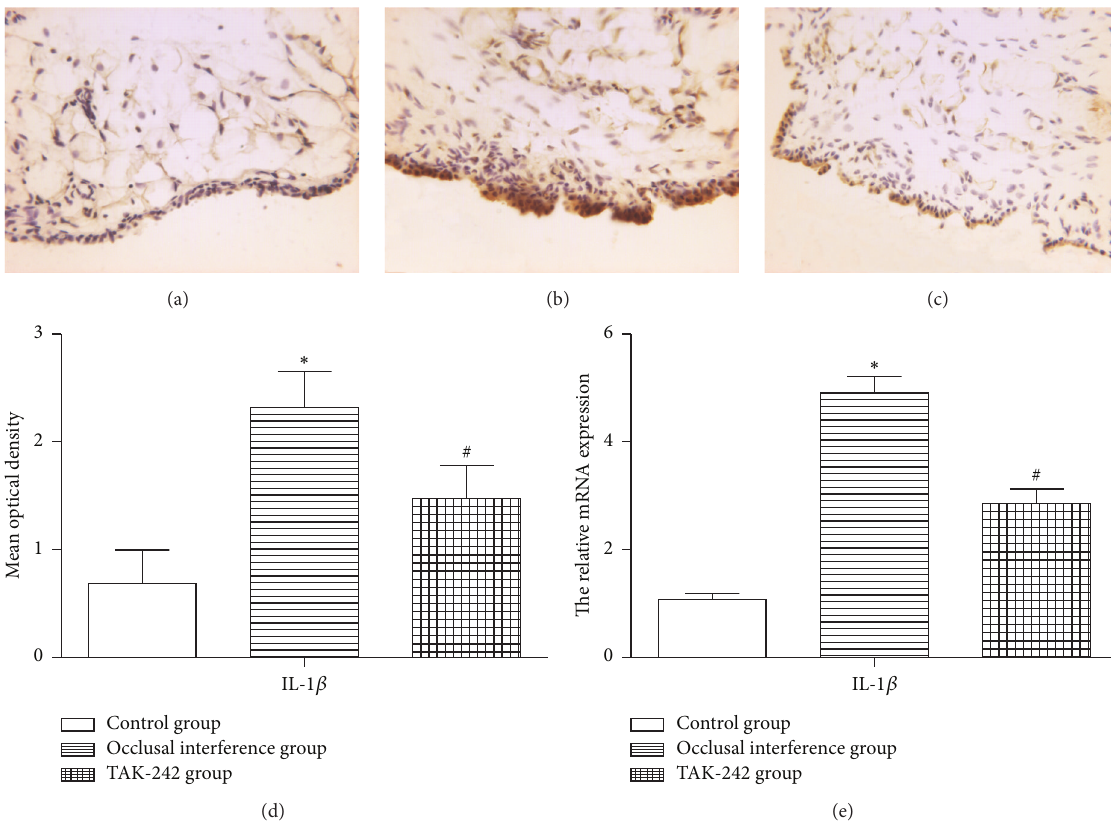
Figure3:EffectofTLR4ontheexpressionofIL-1 𝛽 inthesynovialmembranes.(a)ImmunohistochemicalstainingforIL-1 𝛽 inthemembranes of the control group. (b) Immunohistochemical staining for IL-1 𝛽 in the membranes of occlusal interference group. (c) Immunohistochemical staining for IL-1 𝛽 in the membranes of TAK-242 group. (d) The mean optical density of each group. (e) The relative mRNA expression of IL-1 𝛽 of each group. As the results shown, in comparison with the control group, the expression of IL-1 𝛽 was significantly increased in the occlusal interference group at both protein and mRNA levels. However, this effect could be inhibited significantly after treatment with the TAK-242. Data shows all the values from independent samples of 𝑛 = 6 , ∗ 𝑃 < 0.05 versus control group and # 𝑃 < 0.05 versus occlusal interference